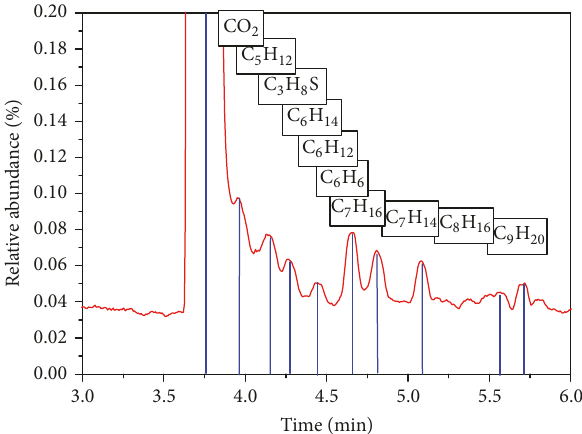
Figure 9: Relationship between relative abundance and retention time for SCCO 2 extraction from coal through GC-MS